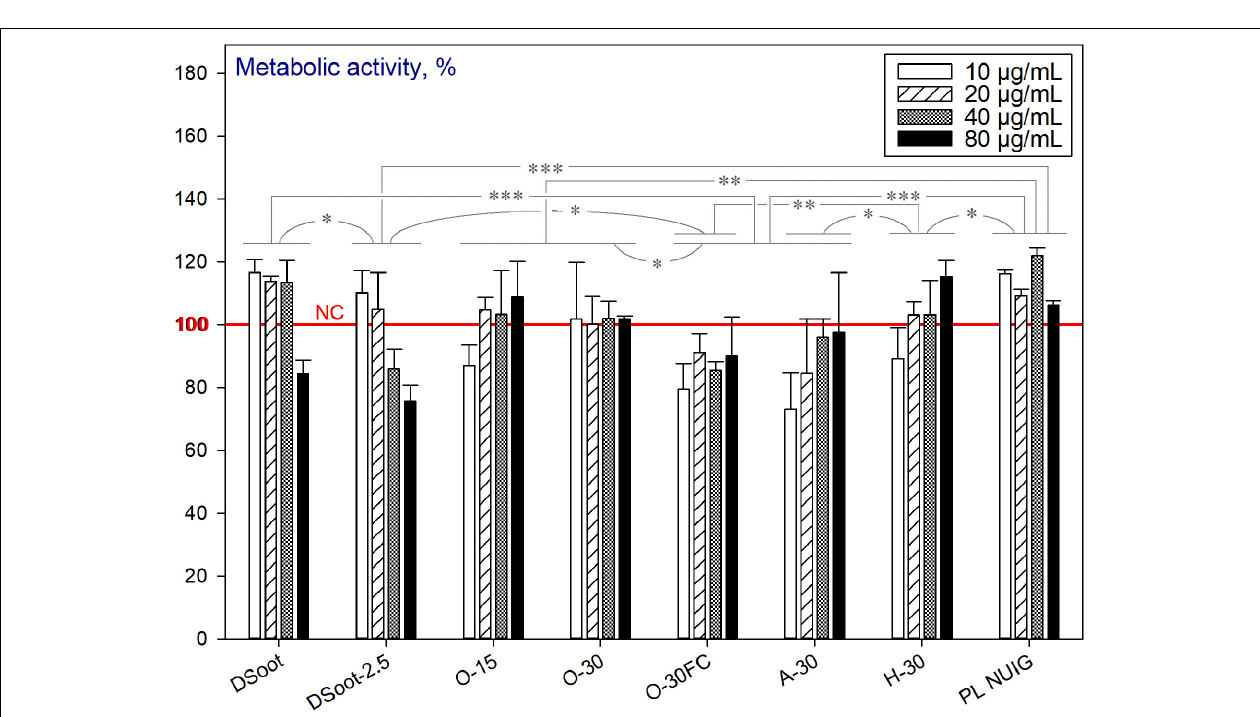
FIGURE 11 | Metabolic activity of HDFs cultured with incompletely sp 2 -C-purified DND, using the alamarBlueTM assay (normalised to the non-treated cells; n = 3; ∗∗∗ p < 0.001; ∗∗ p < 0.01; ∗ p < 0.05; ± SD).